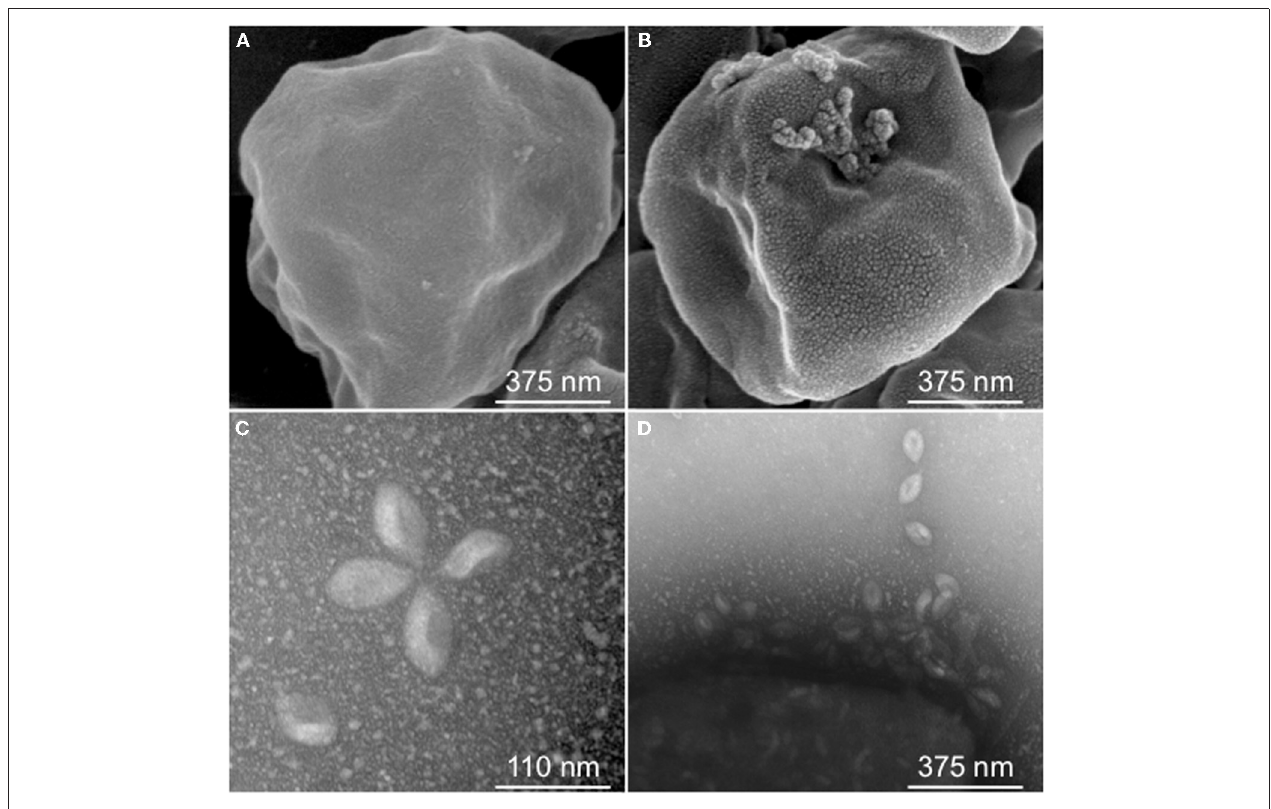
FIGURE 1 | Sulfolobus Spindle-shaped Virus (SSV) infection. Scanning Electron Micrograph (SEM) of Sulfolobus solfataricus strain G θ either uninfected (A) or infected with SSVRH (B) ; (C) Transmission Electron